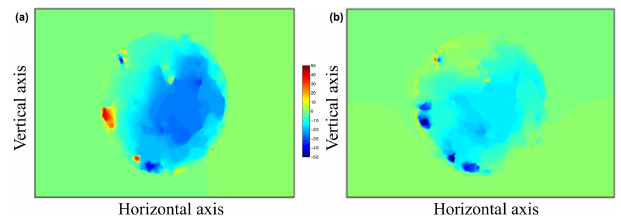
Figure 13. Horizontal and vertical translation of pixels between two successive frames computed using optical flow. We plot the (a) hor- izontal translation and (b) vertical translation of pixels.